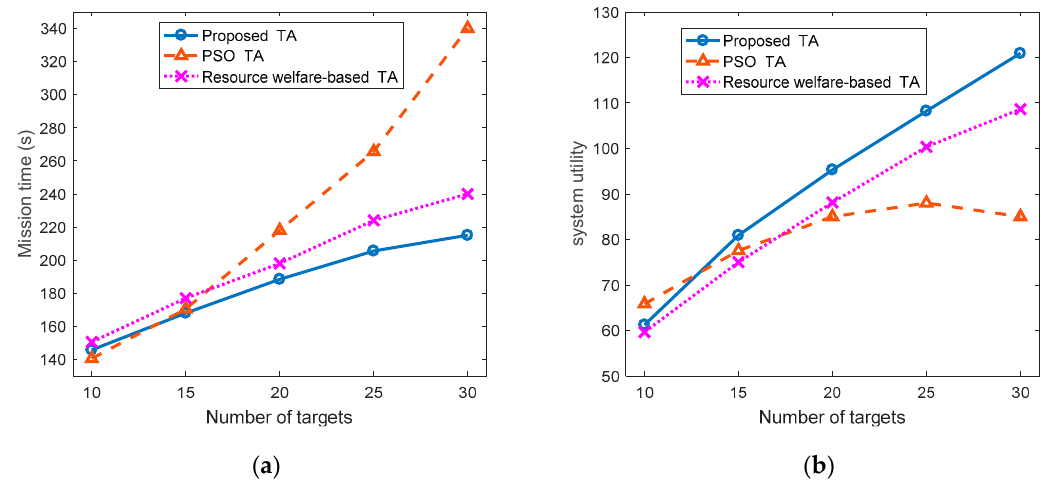
Figure 7. Comparison of these task allocation (TA) algorithms. ( a ) Average mission completion time; ( b ) average system utility.